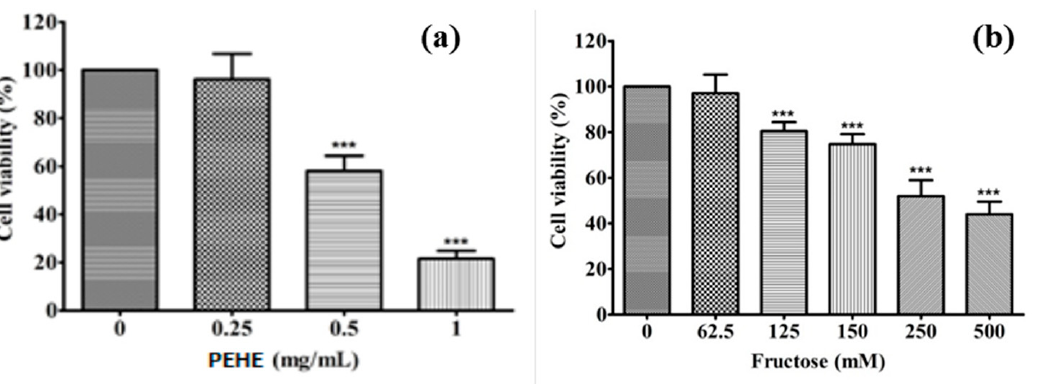
Figure 3. Effects of PEHE ( a ) and fructose ( b ) extract on RIN-m5F cell viability. RIN-m5F cells were treated with fructose or the polyphenol-enriched extract of hawthorn fruit (PEHE) for 24 h. Data are expressed as mean ± SD (n = 3); *** p < 0.001 compared to control.